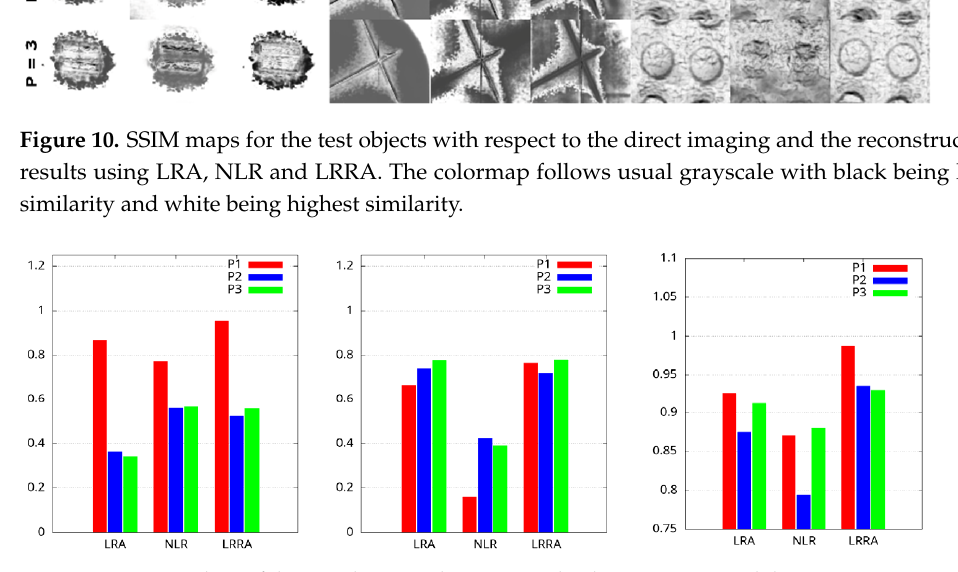
Figure 11. SSIM values of the test objects with respect to the direct imaging and the reconstruction